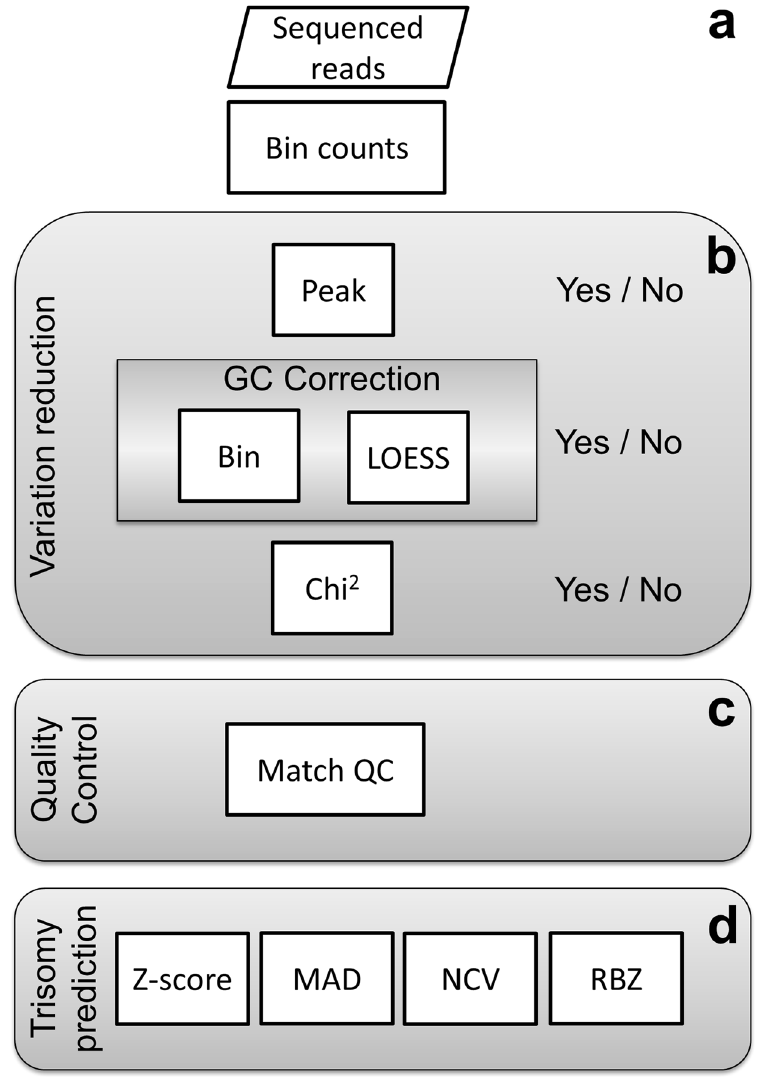
Figure 1. Flowchart showing the analysis steps. ( a ) First, sequenced reads are aligned, partitioned into 50,000 bp bins and counted. These bins are the units for further analysis and data quality can be improved using zero or more variation reduction methods. ( b ) Peak correction removes bins showing an unusually high coverage compared with the average coverage of bins on the same chromosome. GC correction corrects for coverage differences between bins having a different GC percentage, using one of two methods: ‘bin’ or ‘LOESS’ GC-correction. The chi-squared variation reduction corrects bins showing a higher variation in read counts between samples than expected by chance. Analysis is performed based on (corrected) read counts. ( c ) The Match QC indicates whether a control-group is informative for the analyzed sample. ( d ) Various algorithms (standard Z-score, MAD-based Z-score, Normalized Chromosome Value and Regression-based Z-score) are used for predicting